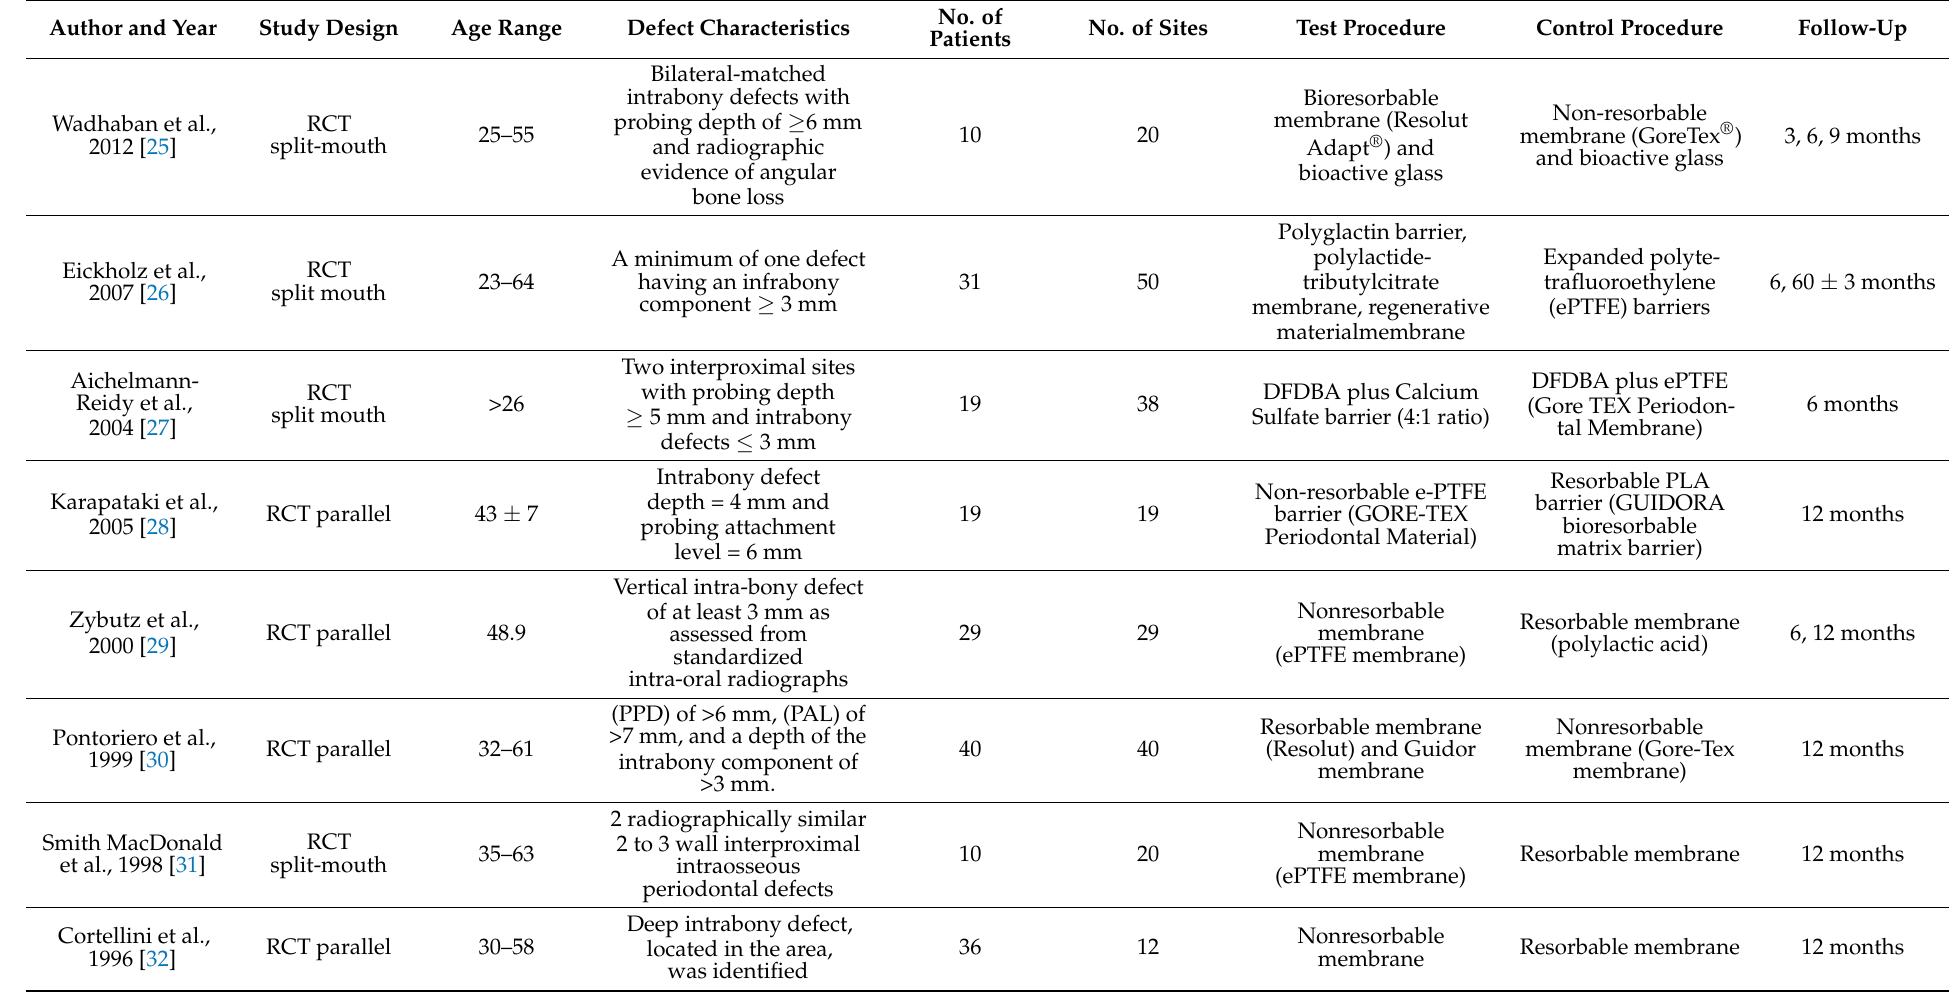
Table 1. Demographic characteristics of the included